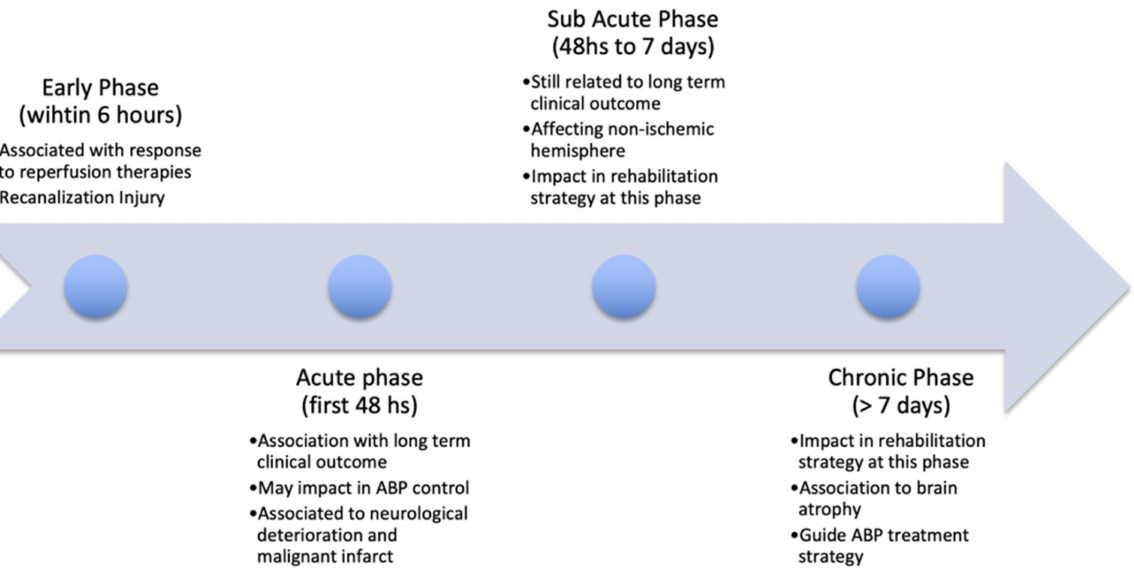
Figure 2. Timeline of the impact of cerebral autoregulation (CA) on ischemic stroke